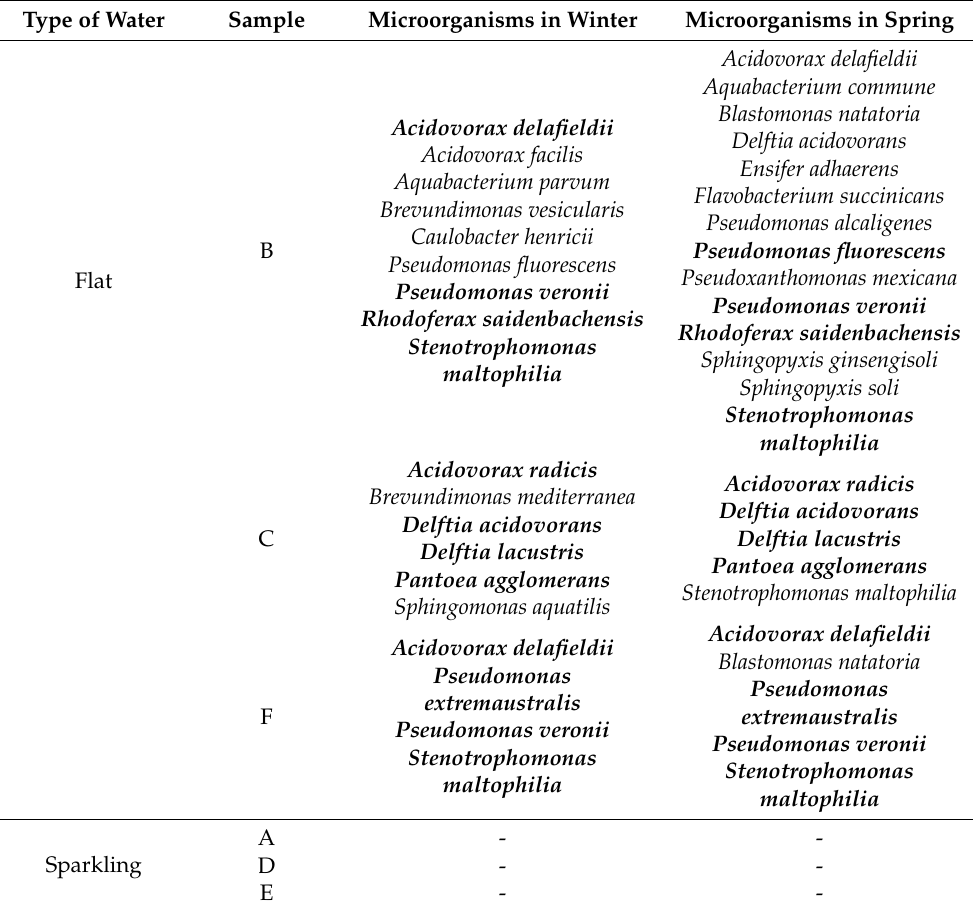
Table 3. Results of Sanger sequencing on colonies isolated from the bottled waters during the shelf- life analysis conducted in winter and spring seasons: codes B, C and F indicate the 3 brands of flat waters, codes A, D and E indicate the 3 brands of sparkling waters. No colonies were isolated from sparkling waters. Microorganisms in bold evidence the germs isolated in both winter and spring